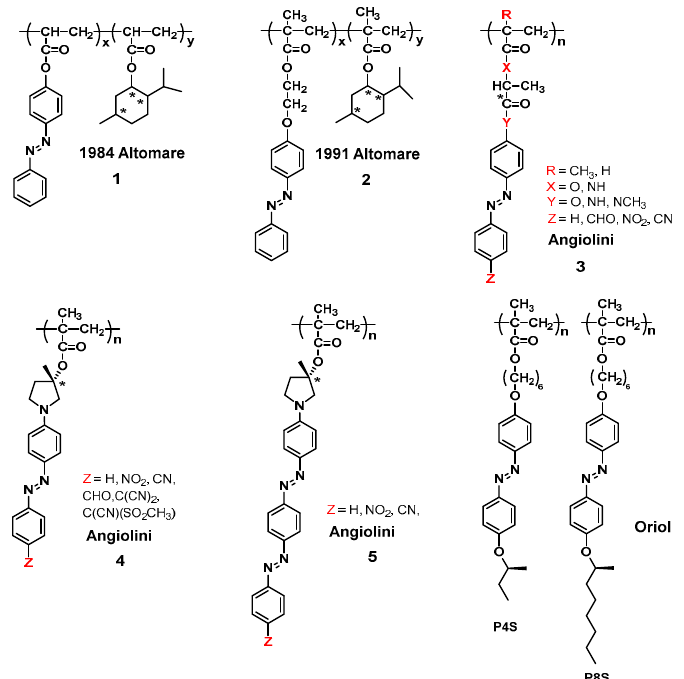
Figure 5. The chemical structures of chiral Azo-polymers 1, 2, 3, 4, 5, P4S and P8S. (R, X, Y, and Z represent different groups).